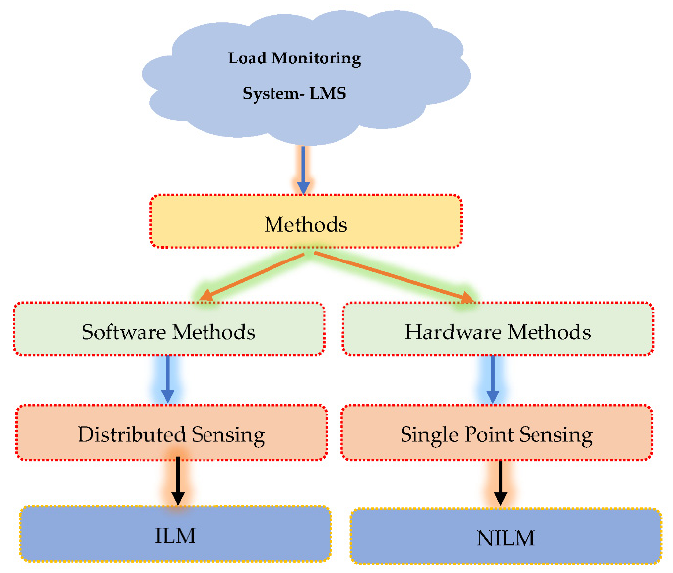
Figure 9. Load Monitoring Methods.